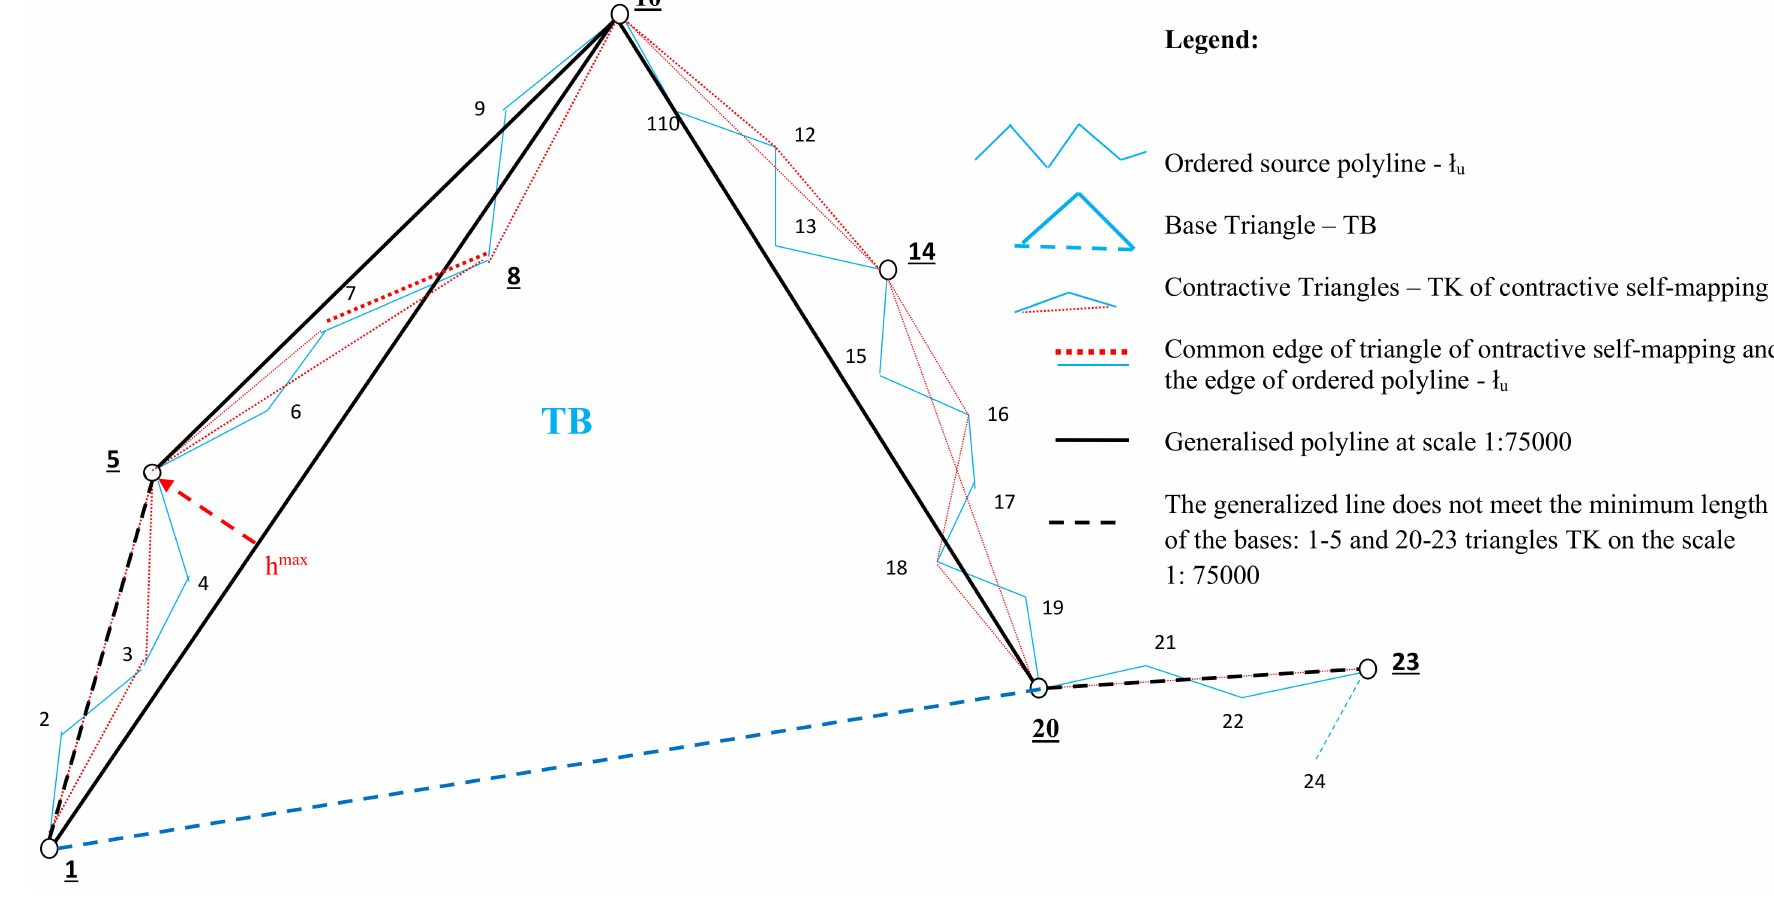
Figure A6. Generalisation of ordered polyline— l u to scale 1:75,000 (from the source scale 1:10,000) with contractive mapping of the triangles TK created in binary tree system and verification of dimensions of triangles in accordance with Couchy condition and minimum dimensions of Salishchev for: bases-p AS = 54.0 m, p min = 56.0 m ± 8.0 m → p AS < p min , heights-h AS = 21.5 m, h max = 17.0 m ± 5.1 m → h AS > h max